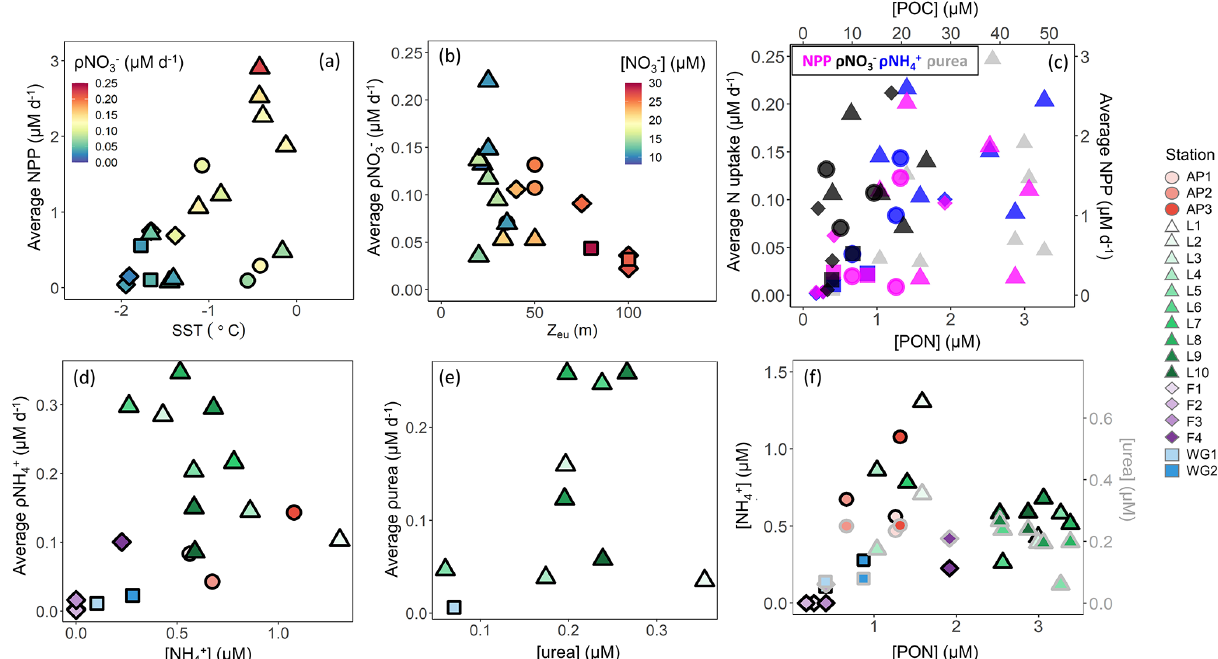
Figure 10. Euphotic zone-averaged rates of (a) NPP versus SST, (b) ρ NO 3 − versus euphotic zone depth ( Z eu ), (c) N uptake (left y axis) versus PON (bottom x axis) and NPP (right y axis) versus POC (top x axis), (d) ρ NH 4 + versus NH 4 + concentration, and (e) ρ urea versus urea concentration, as well as (f) the concentrations of NH 4 + (black-outlined symbols, left y axis) and urea (grey-outlined symbols, right y axis) versus PON at each station. The symbols in panel (a) are coloured by ρ NO 3 − , in panel (b) by NO 3 − concentration, and in panel (c) by NPP (pink), ρ NO 3 − (black), ρ NH 4 + (blue), and ρ urea